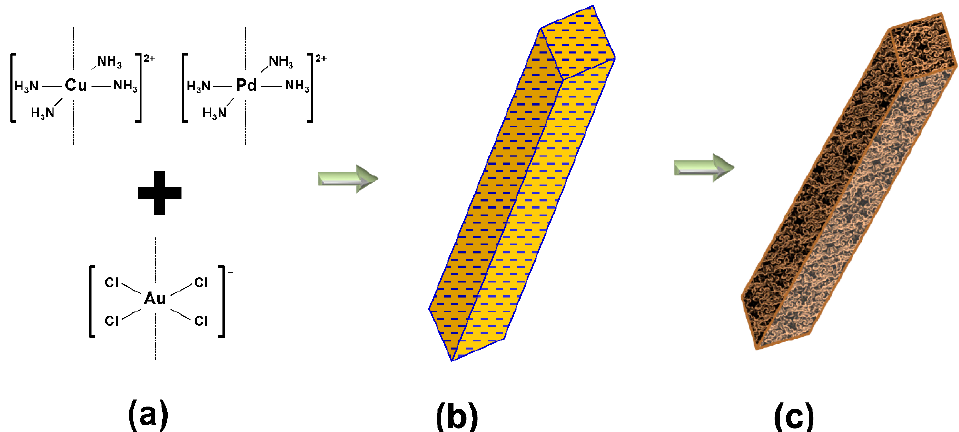
Figure 1. Nanofoam and macrobeam synthesis scheme. ( a ) Addition of [AuCl 4 ] − with [Cu(NH 3 ) 4 ] 2+ and [Pd(NH 3 ) 4 ] 2+ ; ( b ) Linear stacking and precipitation of square planar complex ions forming salt crystal precursors; ( c ) Reduction of Au-Cu-Pd salt precursor to a porous macrobeam.